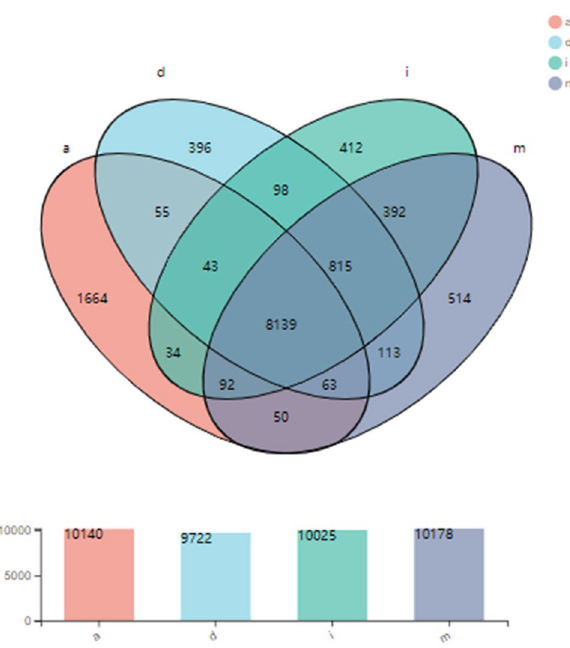
Figure 6. Venn diagram showing the unique and overlapping transcripts expressed in the four stages of fruiting body development in C.